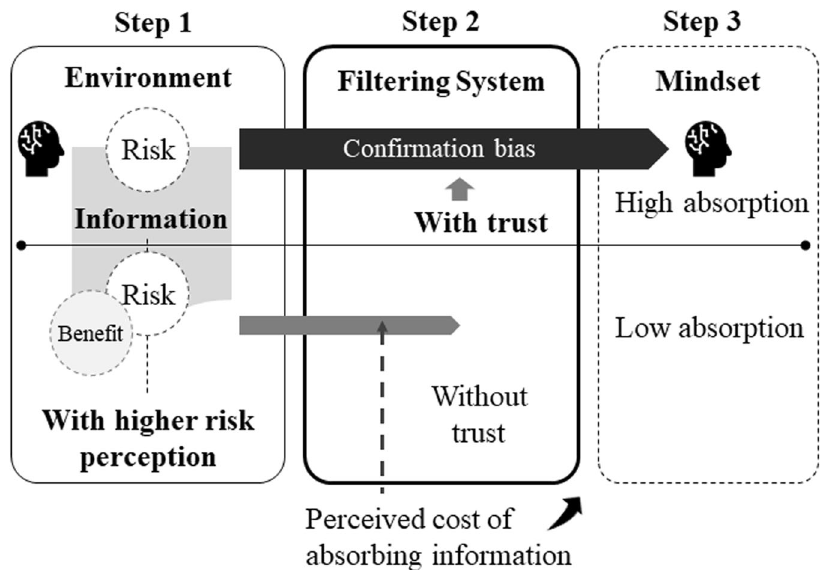
Fig. 3 Information fi ltering system based on the “ mindsponge mechanism ” -treated negative topics in bene fi t-risk